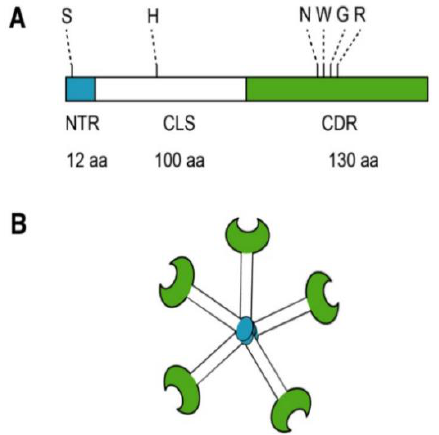
Figure 2. Structure of Gal-3. ( A ) Gal-3 protein structure consists of an N terminal Domain (NTD), which has an N terminal region of 12 amino acids (aa) and contains a serine 6 (S) phosphorylation site. The carbohydrate recognition domain (CRD) of 130 aa comprises the C-terminal and contains the anti-death motif or Asp-Trp-Gly-Arg (NWGR); ( B ) Pentameric structure of Gal-3. Reproduced with permission